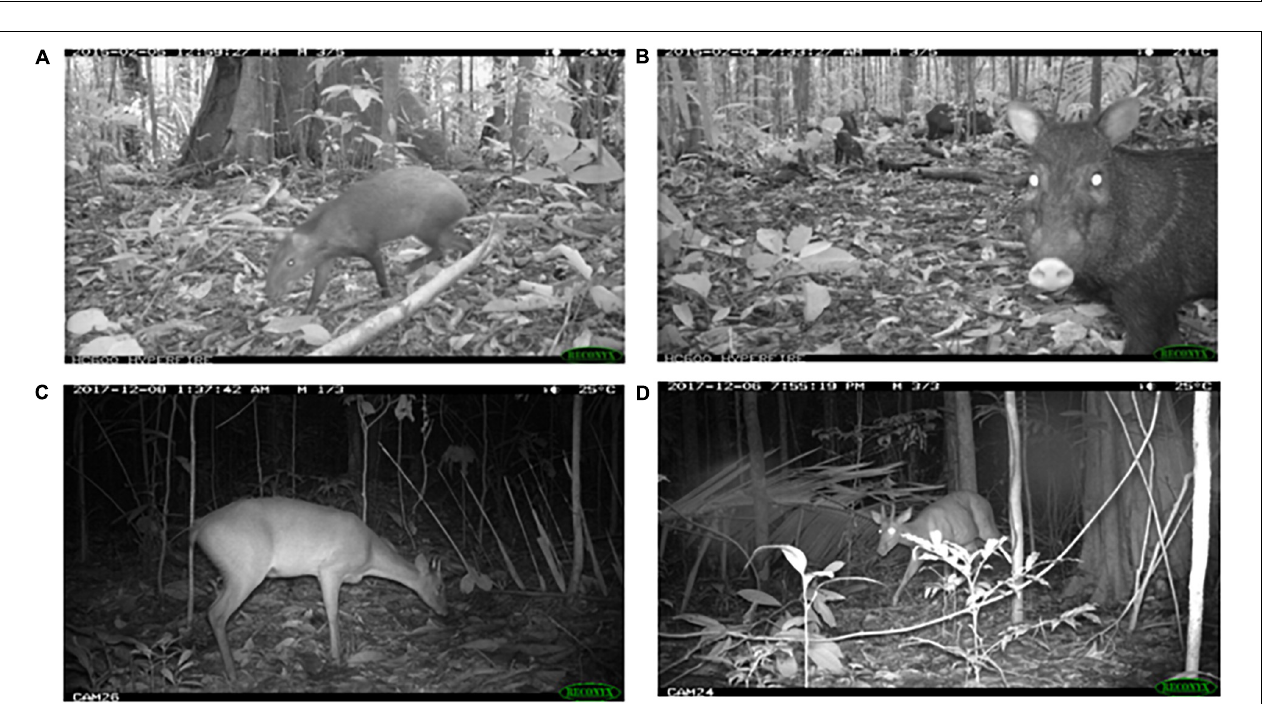
FIGURE 4 | Some camera trap images of the ground-dwelling frugivores observed beneath fruiting Virola kwatae and V. michelii trees in forest patches along Road “Nationale 2” (RN2) between Régina and Saint-Georges, French Guiana, in February 2015 and December 2017: (A) Red-rumped agouti ( Dasyprocta leporina ); (B) collared peccary ( Pecari tajacu ); (C) gray brocket deer ( Mazama gouazoubira ); (D) red brocket deer ( Mazama americana ).